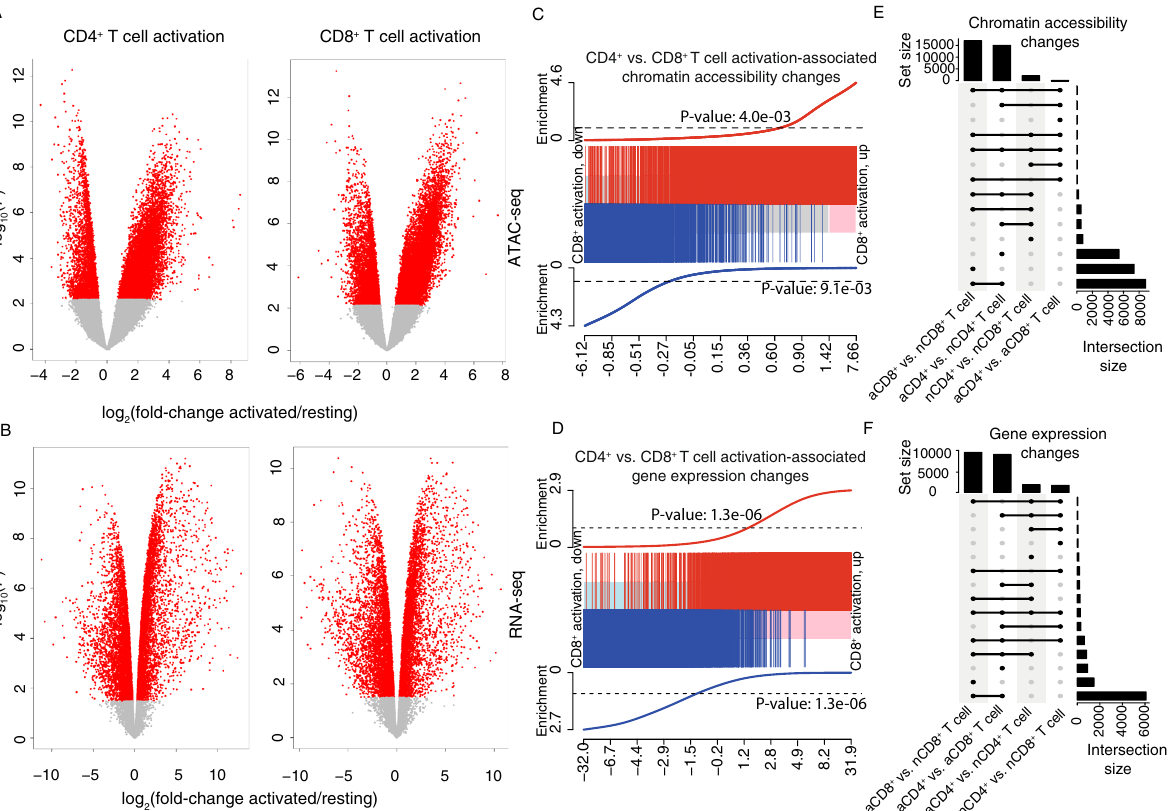
Figure 2. T cell activation induces extensive changes in chromatin accessibility and gene expression that are comparable between CD4 + and CD8 + T cells. ( A ) Volcano plots showing the magnitude of differential accessibility in activated CD4 + and CD8 + T cells. Each point represents a peak with significant changes highlighted in red (FDR < 0.05). ( B ) Volcano plots showing the magnitude of differential expression in activated CD4 + and CD8 + T cells. Each point represents a gene with significant changes in red (FDR < 0.p05). ( C ) Barcode enrichment plot showing that DA peaks in CD4 + T cells are similarly ranked in CD8 + T cells. Peaks are ordered from left to right on the plot from most down-regulated to most up-regulated upon activation in CD8 + T cells, forming a shaded middle horizontal bar, with log2-fold-changes shown by the x-axis. DA peaks significantly up-or down-regulated upon activation in CD8 + T cells (FDR < 0.05) are marked by red and blue vertical bars, respectively. The red enrichment worm at the top of the plot shows the local density of red vertical bars while the blue enrichment worm at the bottom of the plot shows the local density for blue vertical bars. P-values show significance of the enrichments (fry gene set tests). The enrichment pattern shows strong concordance of the CD4 + and CD8 + changes. ( D ) Barcode enrichment plot showing that DE genes in CD4 + T cells are similarly ranked in CD8 + T cells. ( E ) UpSet plot showing the number of DA peaks for each comparison (activated vs. resting CD8 + T cells, activated vs. resting CD4 + T cells, resting CD4 + vs. resting CD8 + T cells and activated CD4 + vs. activated CD8 + T cells) and their intersections. Vertical bars illustrate the total number of DA peaks for each comparison. Horizontal bars show the number of common DA peaks (intersection size) for a given set of comparisons (filled connected circles). ( F ) UpSet plot showing the number of DE genes for the same comparisons as in ( E